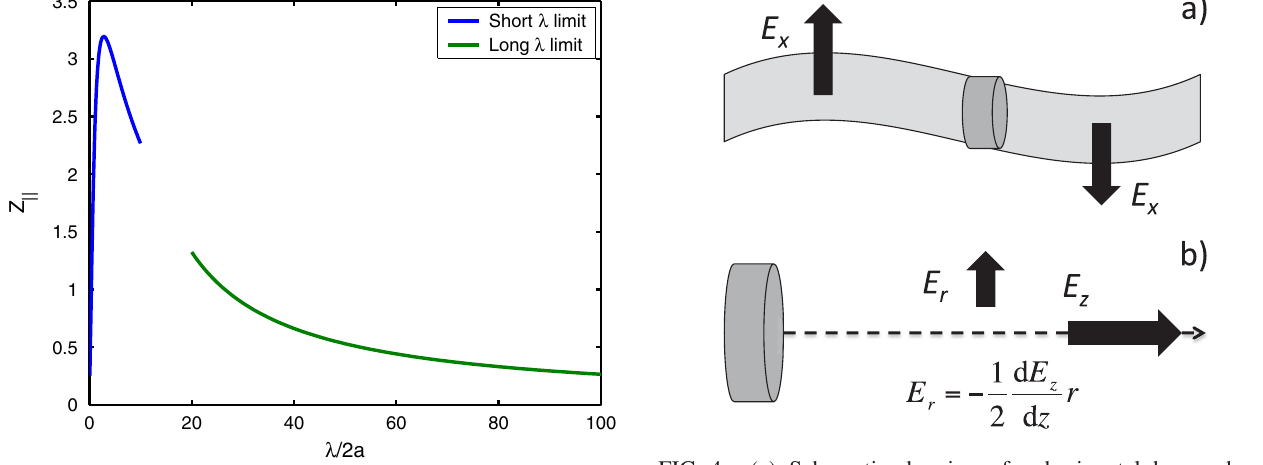
FIG. 3. (Color) Longitudinal impedance (arbitrary units) in long and short wavelength approximations as a function of the wave- length normalized to the beam diameter, 2 a . The impedance reaches its maximum at (cid:9) (cid:8) 5 a . The b=a ratio is equal to 5.